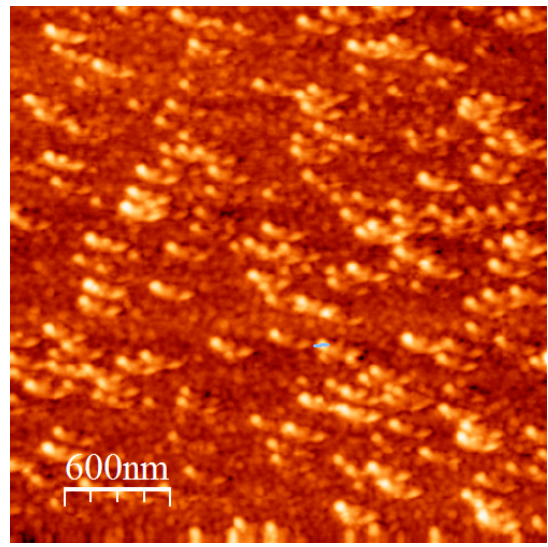
Figure 12. AFM height image of the PS(PHIC) 2 36/20/80.